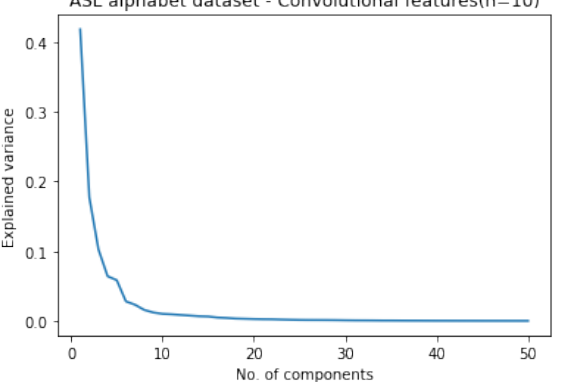
Figure 9. Scree graph on convolutional features-ASL